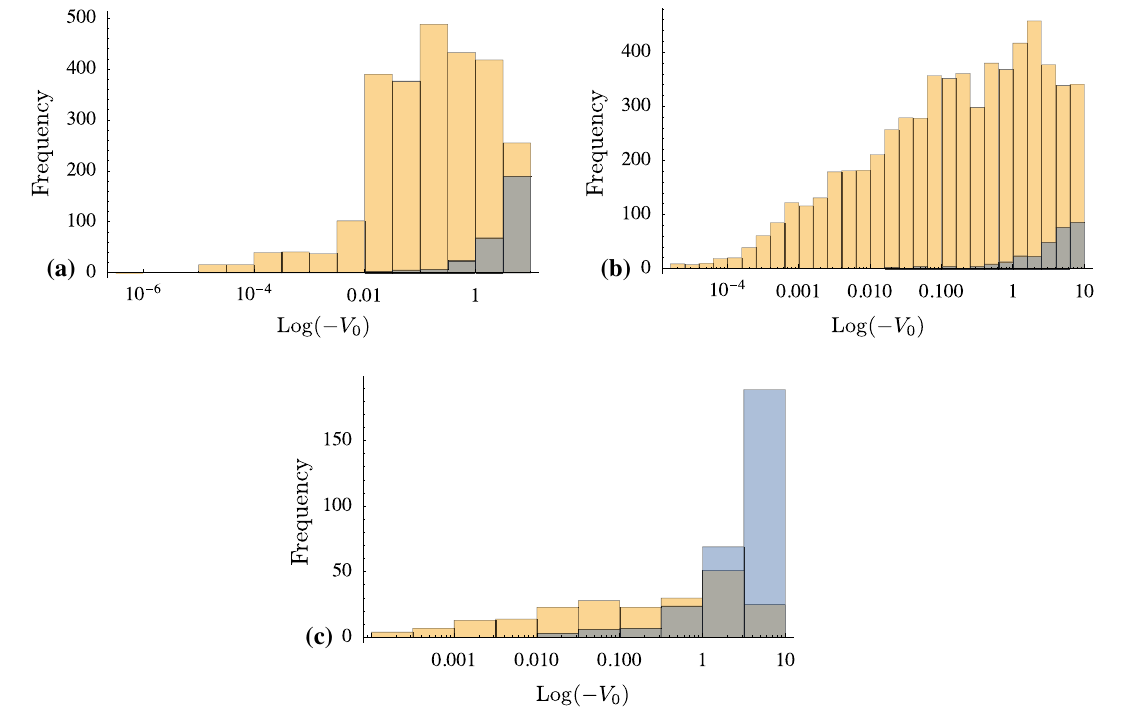
Fig. 5 Distributionsofvacuaobtainedforhierarchicalfluxes: a Kähler (K), b complex structure (CS) and c axio-dilaton (AD) as the lightest modulus. The critical points obtained by the ANN + GA are given in